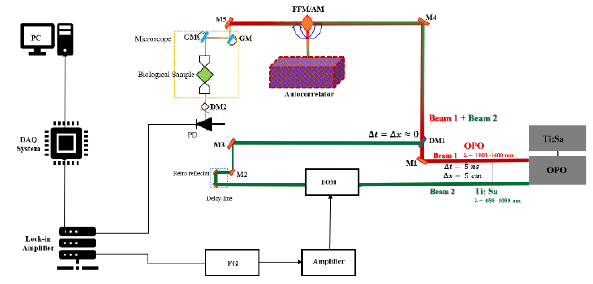
Fig. 1 . Optical architecture for spectral characterization single